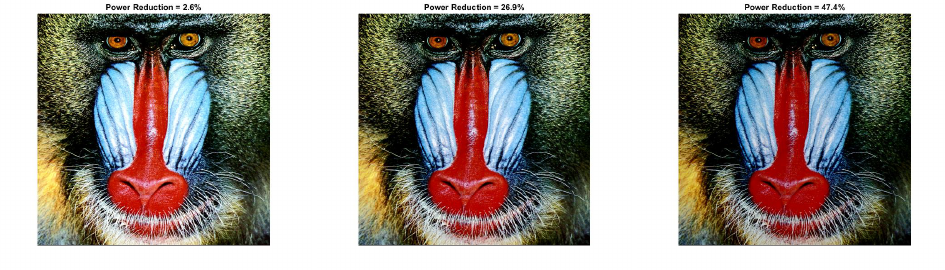
Figure 12. Car resulted image I new using Y CBCS (without HE) for a = 0.7 and b = [10:10:30].